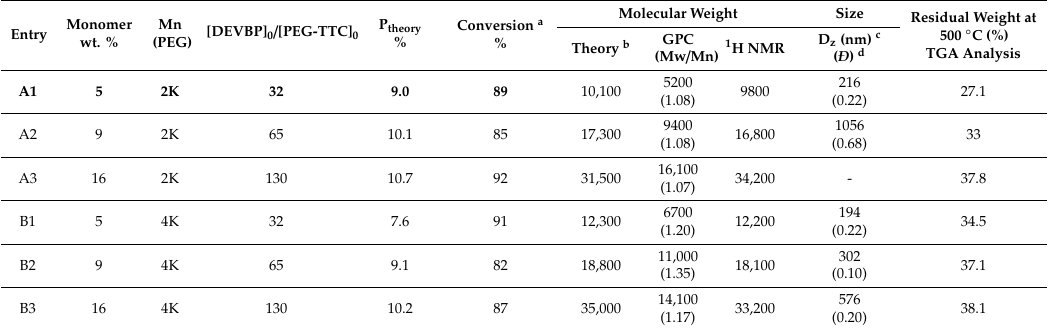
Table 1. Polymerization and colloidal properties of polymer particles synthesized via the RAFT Emulsion homopolymerization of DEVBP.